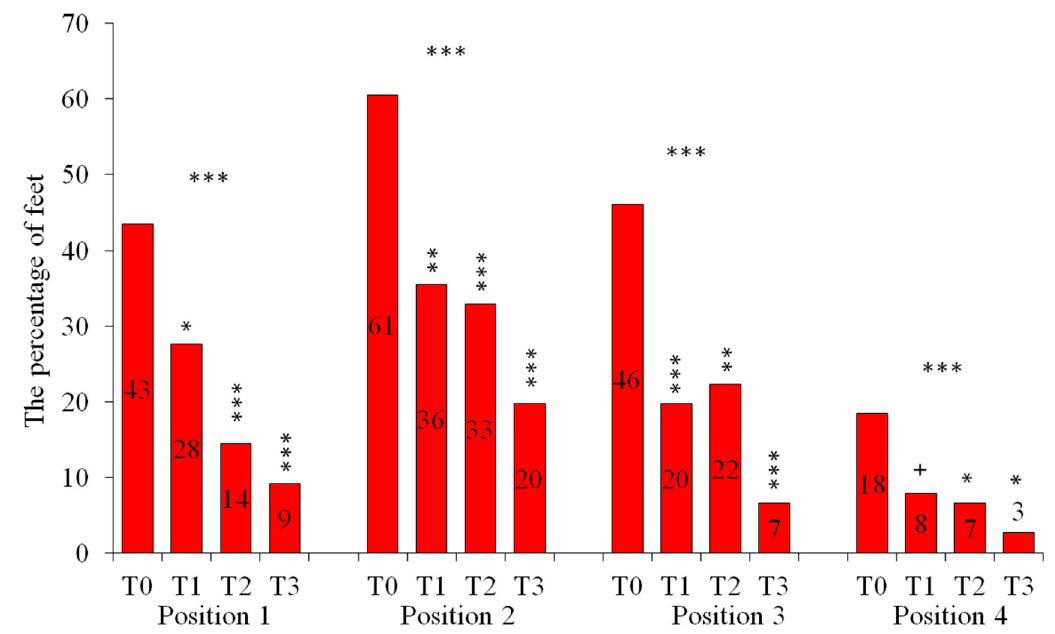
Figure 4. Percentage of feet with pain before treatments (T0) and after 1st (T1), 2nd (T2) and 3rd (T3) treatment when loading feet in different positions. Position 1—pain when standing on straight legs. Position 2—pain when shifting weight to the forefoot. Position 3—stabbing pain in the front of the foot when walking. Position 4—pain when transferring weight to the heel area. *** p < 0.001, ** p < 0.01, * p < 0.05, + p = 0.054.